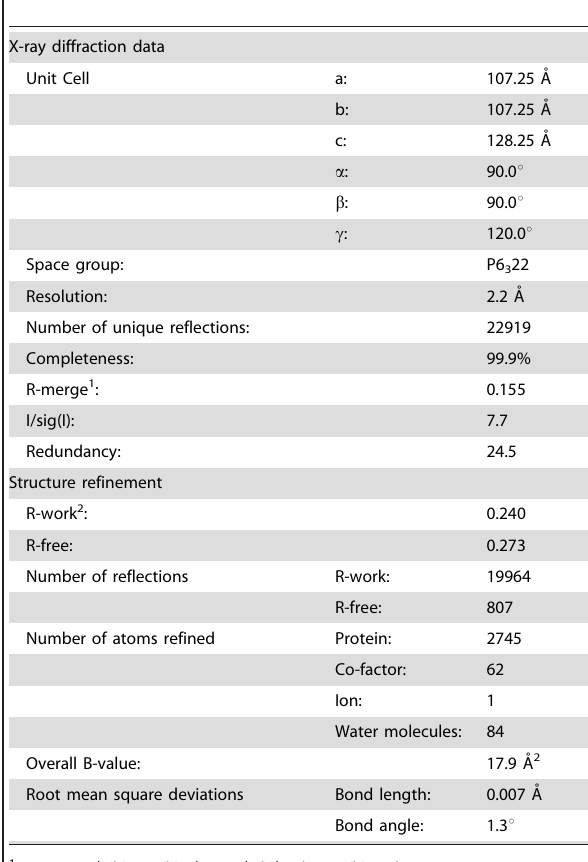
Table 1. Data collection and refinement